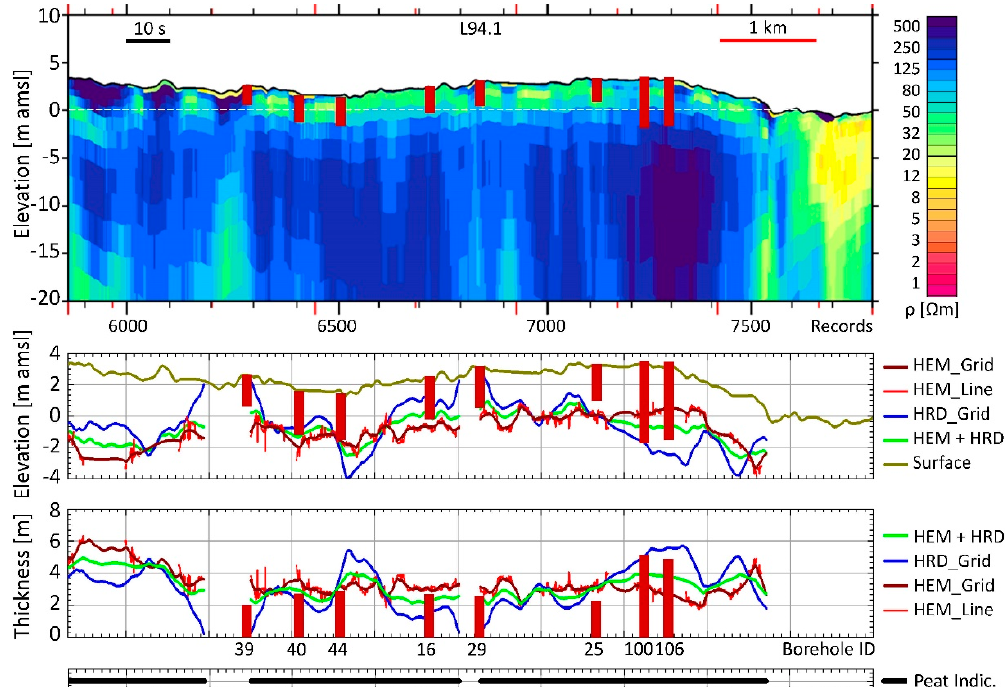
Figure 15. Vertical resistivity section along flight line L94.1 (above) derived from smooth inversion of HEM data, and peat elevations / thicknesses (below) derived from HEM or / and HRD data in comparison with peat ranges found in boreholes (brown columns). HEM_line: SG analysis along lines, HEM_Grid: gridded HEM results, HRD_Grid: gridded HRD results, HEM + HRD: combined results. Surface elevation and a peat indicator (derived from airborne data) are also shown.